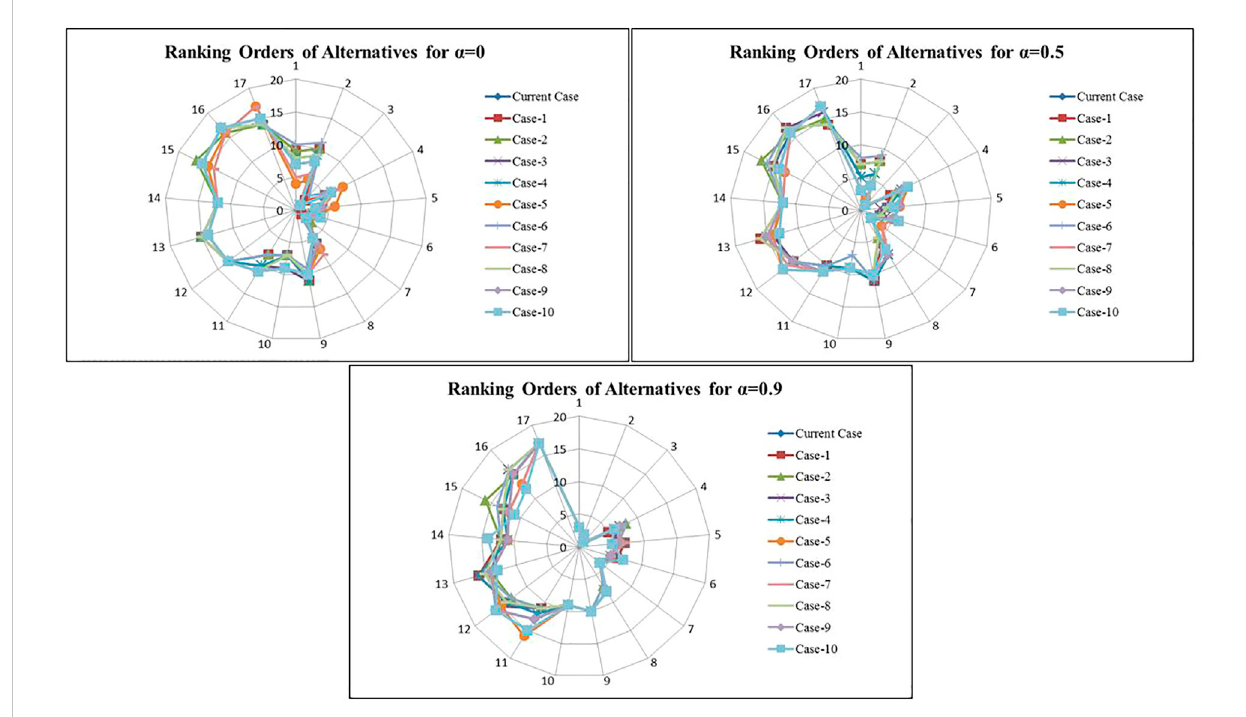
FIGURE 3 Ranking orders of alternatives for α = 0, 0.5, and 0.9 according to ten different cases.